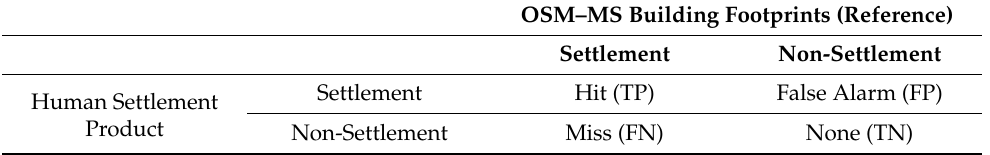
Table 2. Confusion matrix comparing settlement/non-settlement values as represented in human settlement products and the OSM–MS building footprint dataset. TP, true positive; FP, false positive; FN, false negative; TN, true negative.